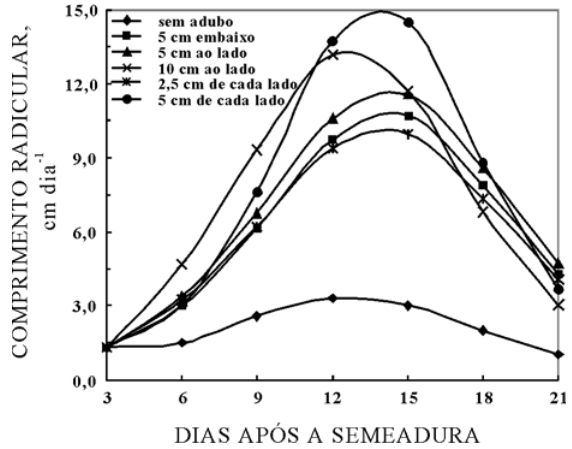
Figura 2. Taxa de crescimento das raízes de algodoeiro de acordo com o tempo e a localização do